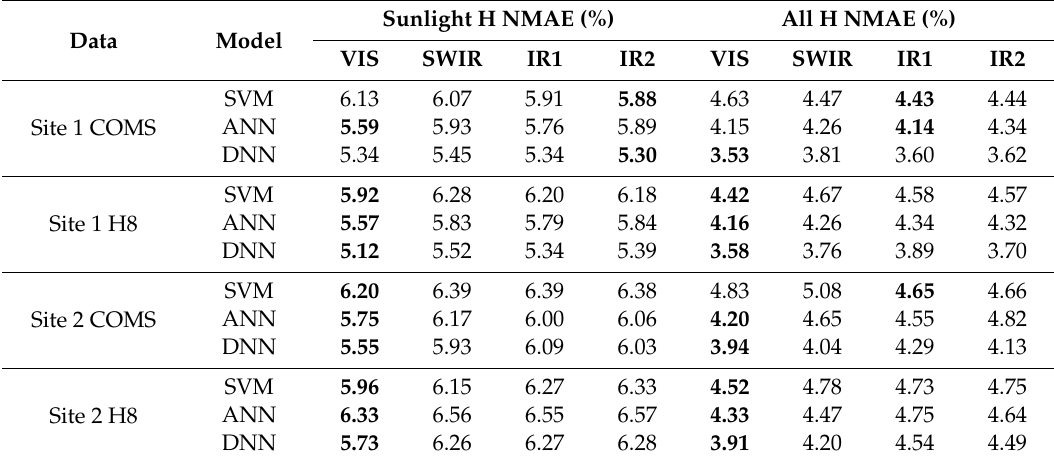
Table 4. NMAE results from 2 h-ahead PV power forecast for COMS and H8 datasets using three forecast models in “Sunlight H” and “All H” time frames (bold text indicates the lowest NMAE for each forecast model).